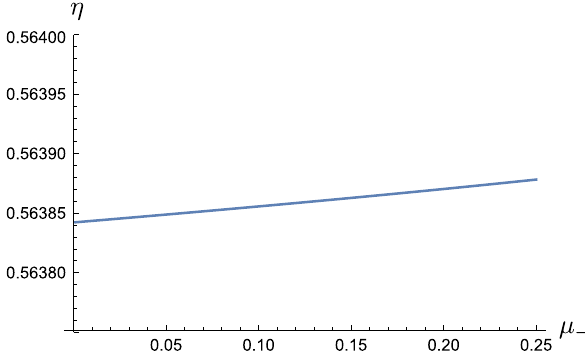
Fig. 3 The efficiency of a heat engine of accelerating black holes is plottedasafunctionof μ − .Here,thecircularcycleisassumedtosatisfy R = 10 with origin at ( V 0 , P 0 ) = ( 100 , 20 )